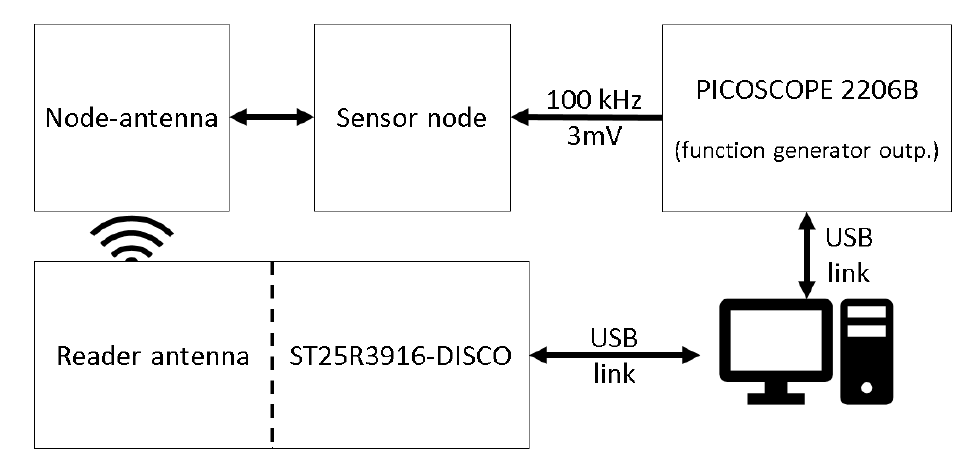
Figure 4. Schematic measurement setup of the system performance tests.